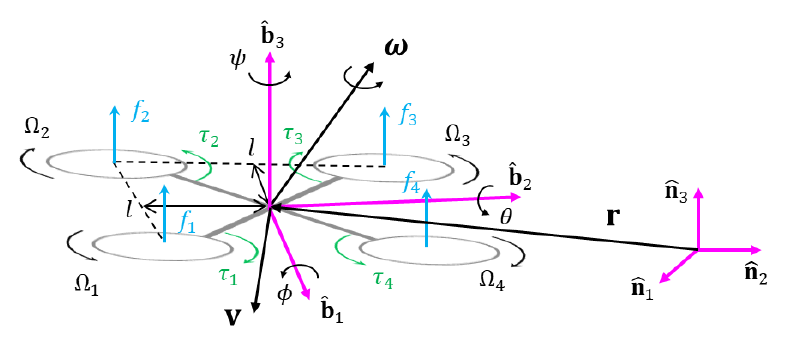
Figure 1. Definitions of the reference frames and